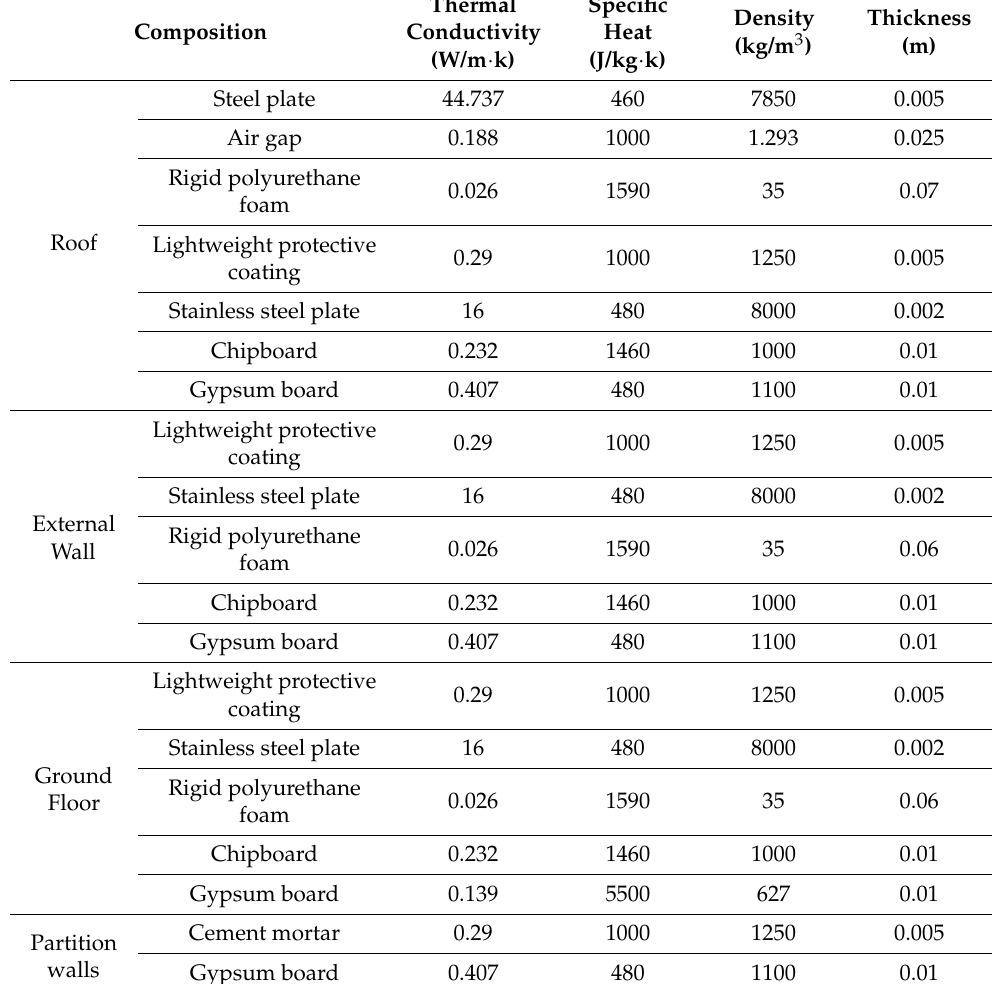
Table 1. Composition details of the container housing prototype (adapted from [31,32]).